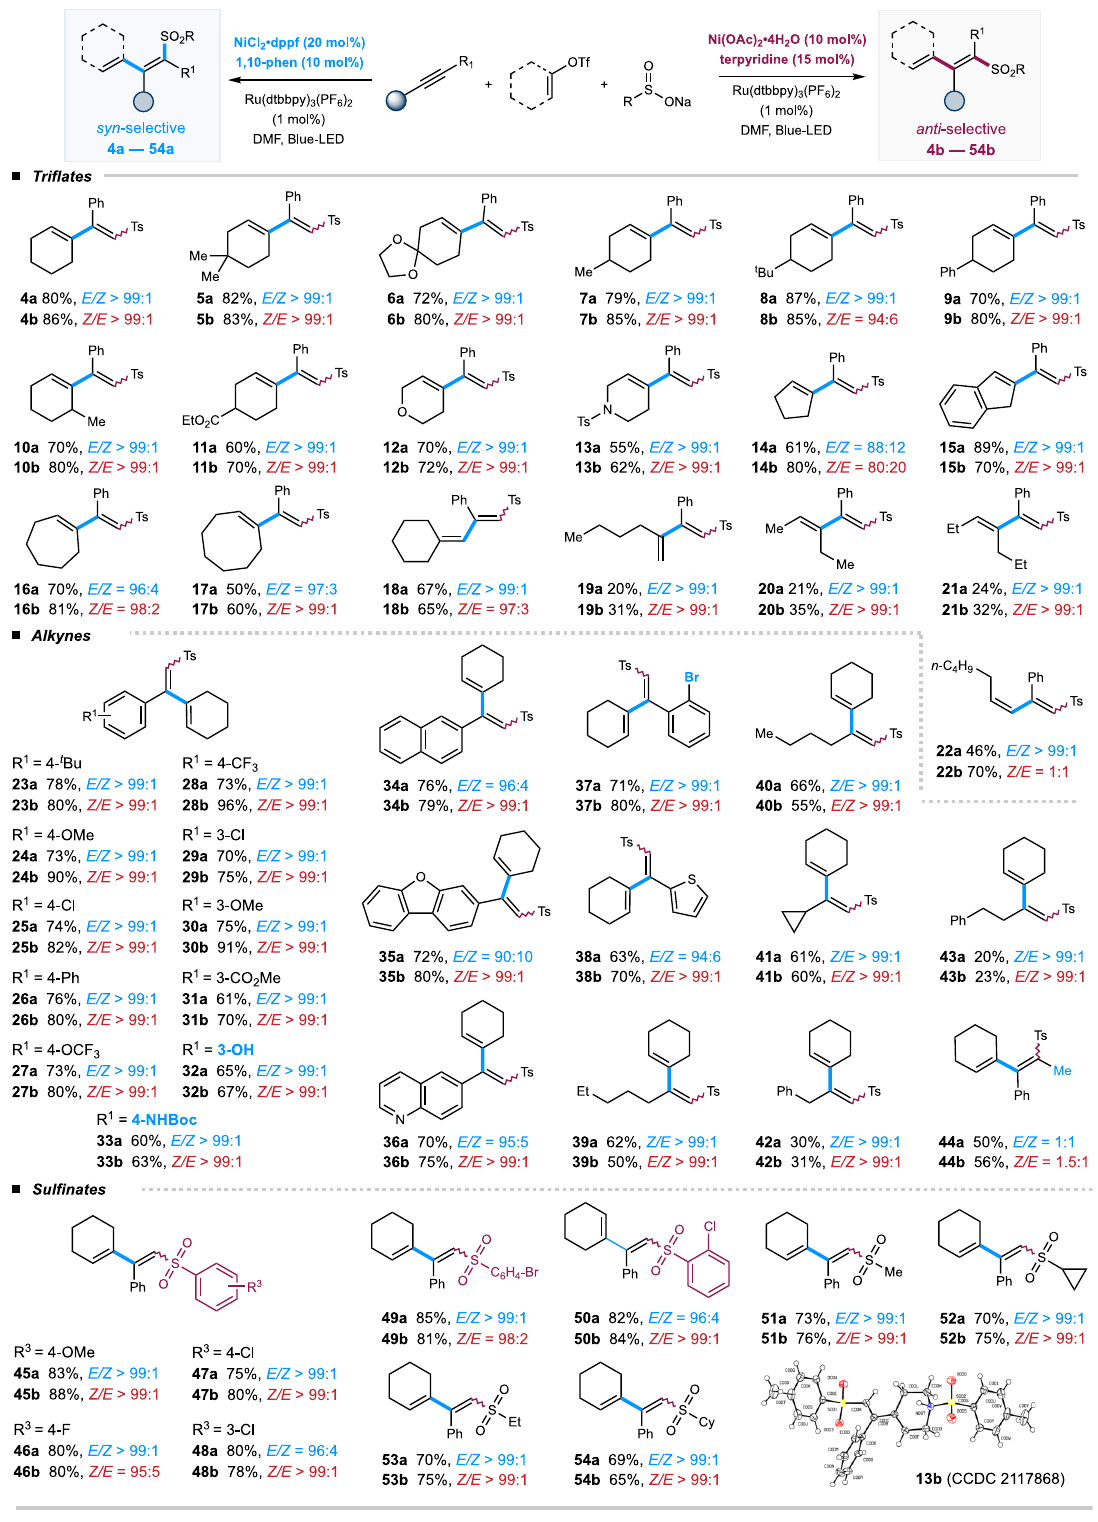
Fig. 2 | Substrate Scope. Reaction conditions: Ru(dtbbpy) 3 (PF 6 ) 2 (1mol%), Ni(OAc) 2 (cid:129) 4H 2 O/tpy (for anti -selective), NiCl 2 (cid:129) dppf/1,10-phen (for syn -selective), alkyne (1.5 equiv.), vinyl tri fl ate (0.1mmol), sodium sul fi nate (1.5 equiv.), DMF [0.04M], 35 o C, blue LED, 6h. Isolated yields. Ts =